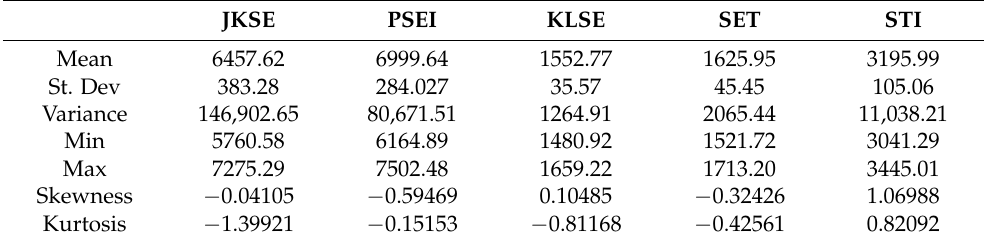
Table 2. Descriptive statistics of ASEAN top 5 stock price indexes.